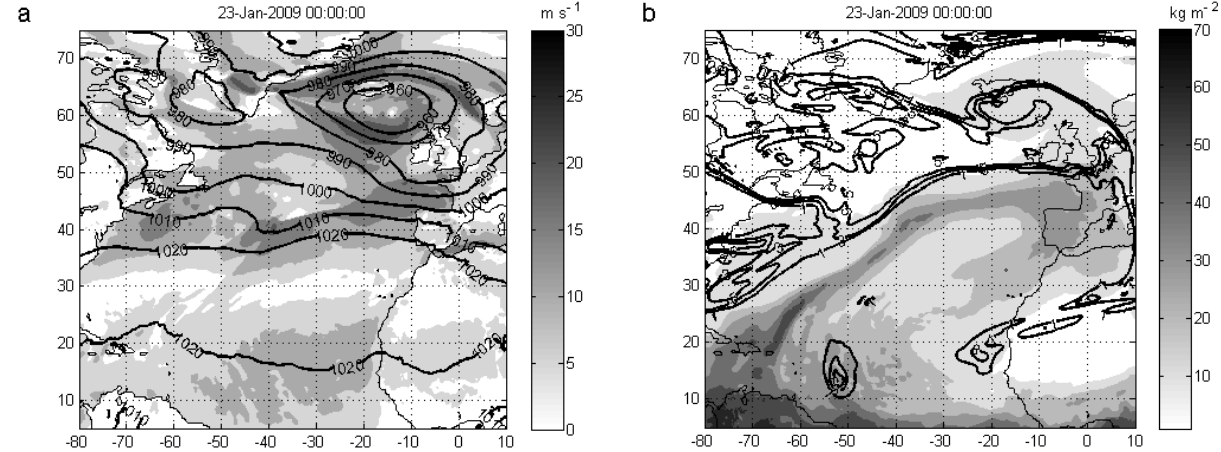
Figure 1. ECMWF analysis of MSLP (solid line) [hPa] and 10 m wind speed [ m s -1 ] (shaded) (a) and PV (solid line) at 300 hPa [PV unit], and TCWV (shaded) [ kg m -2 ] (b) at 00 UTC